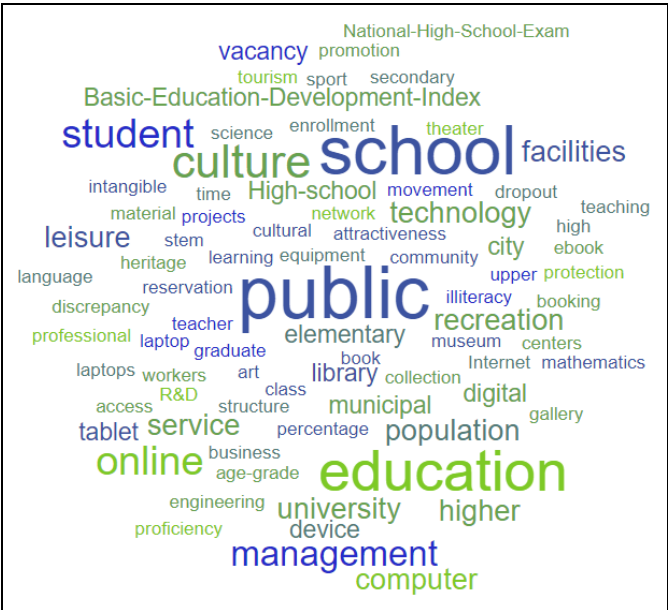
Figure 12. Most frequent indicators within the theme of “education”.